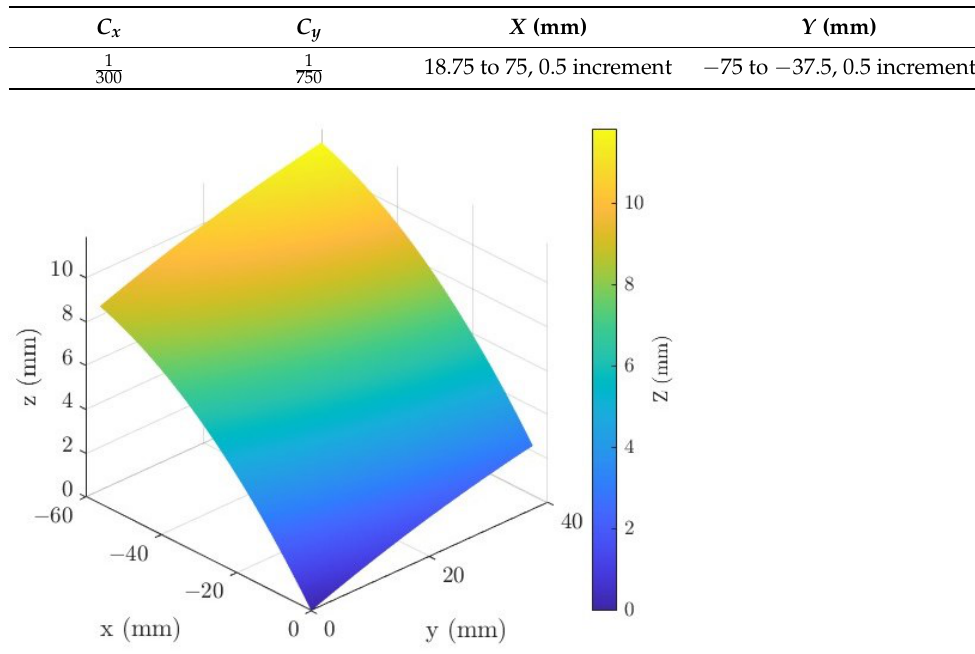
Table 1. Values used in Equation (1) for freeform surface generation.